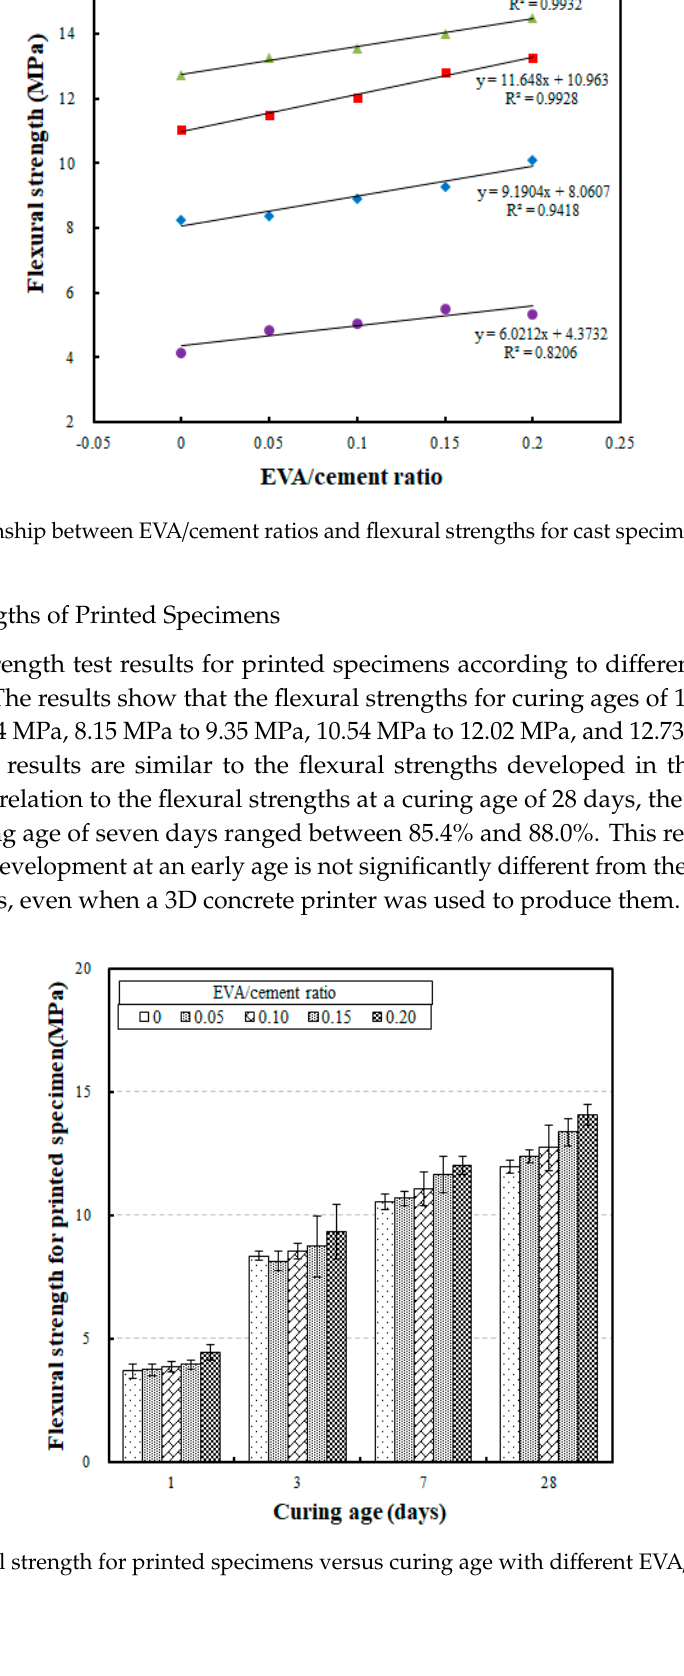
Figure 9. Flexural strength for printed specimens versus curing age with different EVA/cement ratios.